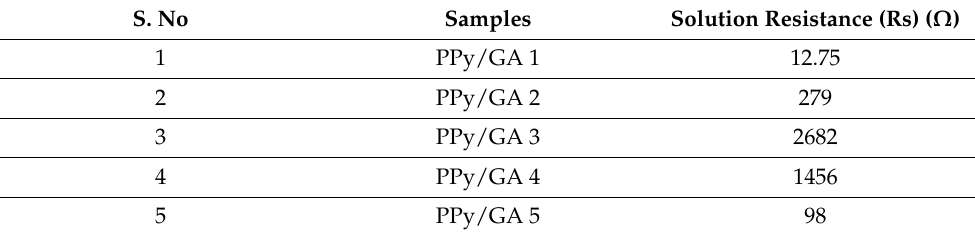
Table 2. Solution resistance of the PPy/GA 1–5